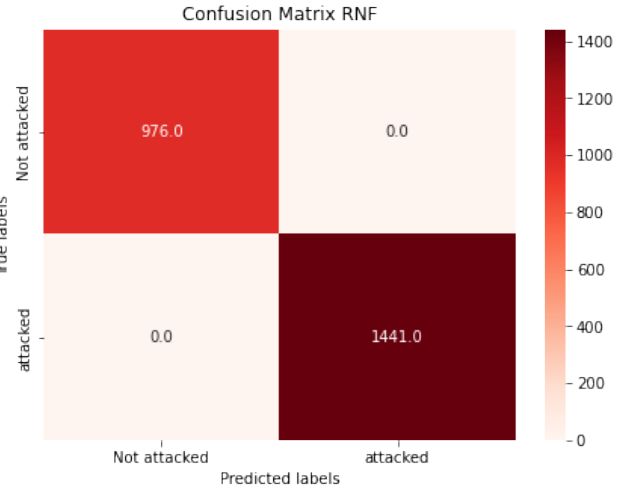
Figure 11. Confusion matrix on prediction of logistic regression classifier.